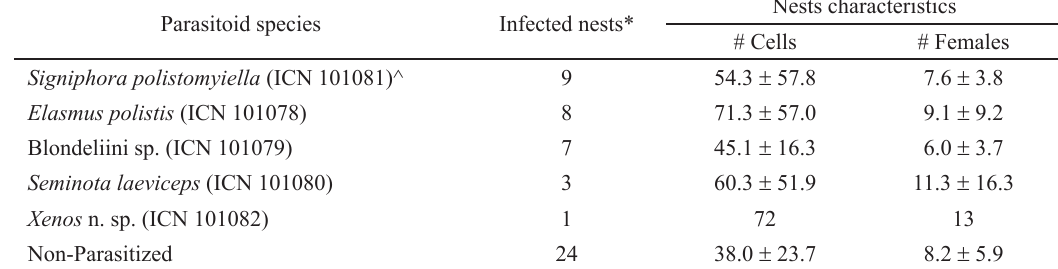
Table 1. Characteristics of the parasitized nest of Polistes myersi where these parasitoids emerged (Mean ± SD). *As